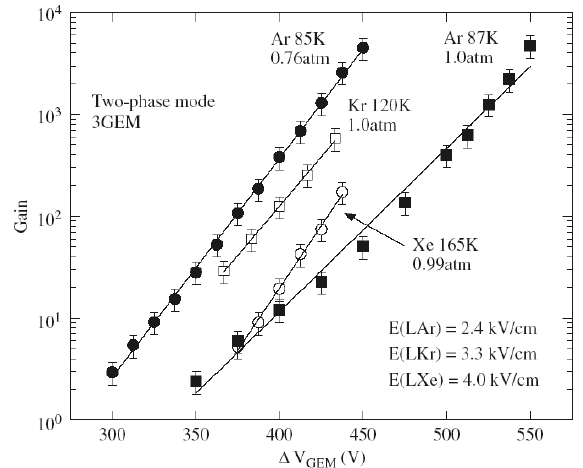
Figure 15. Gain characteristics in two-phase Ar, Kr and Xe detectors with triple-GEM multiplier charge readout [4,40]. The appropriate temperatures, pressures and electric fields in the liquids are indicated. The multiplier active area was 2.8 × 2.8 cm 2 ; the maximum gains were limited by discharges.